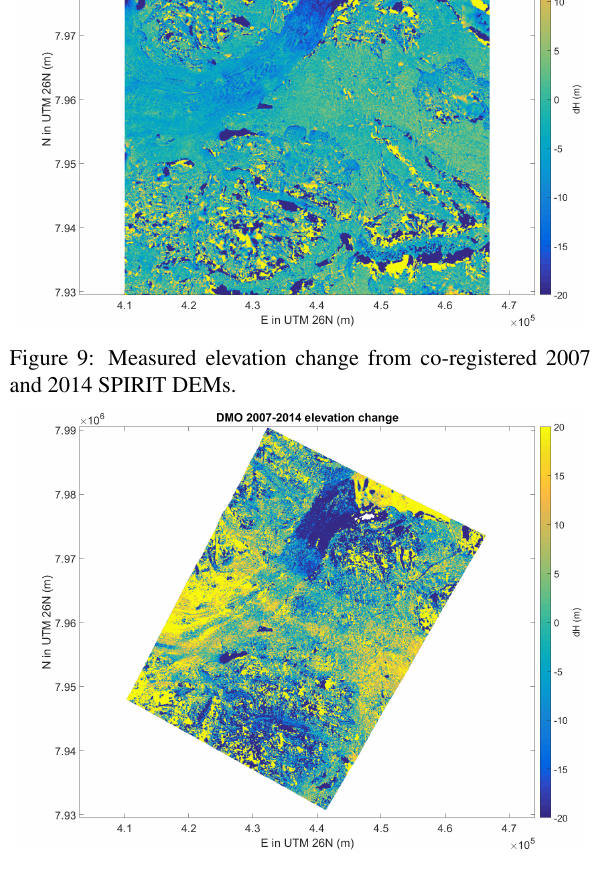
Figure 10: Measured elevation change from co-registered 2007 and 2014 DMO